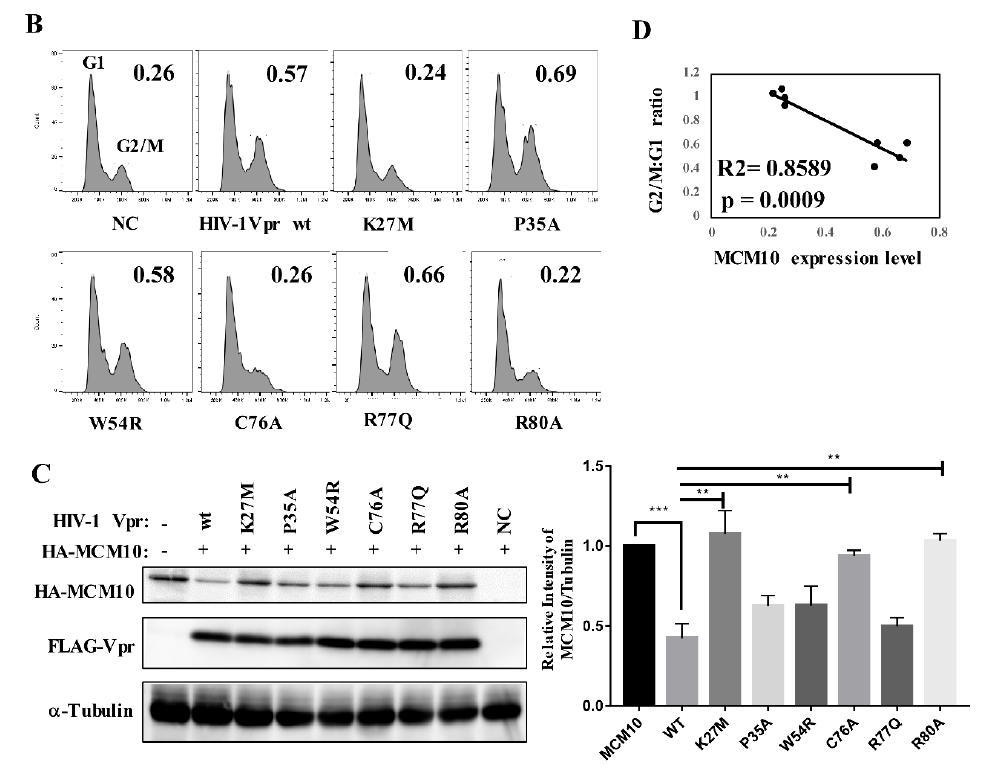
Figure 8. MCM10 degradation by HIV-1Vpr is positively correlated with G 2 /M arrest function of HIV-